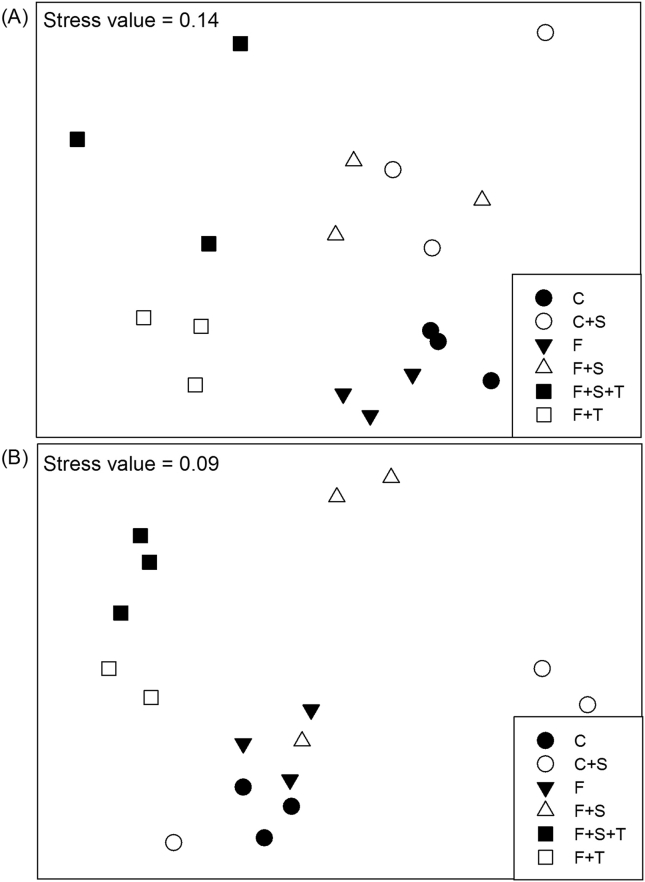
Bray-Curtis similarity-based non-metric multidimensional scaling plot (nMDS) of normalized TRFLP data obtained from MspI-digested 18S rDNA amplicons visualizing the differences in fungal community composition in the clayey (A) and sandy (B) soil according to the following treatments: uncoated maize (C), uncoated maize with S. hermonthica (C + S), coated maize with ‘Foxy-2’ (F), coated maize with ‘Foxy-2’ and S. hermonthica (F + S), coated maize with ‘Foxy-2’ and T. diversifolia (F + T) and coated maize with ‘Foxy-2’, S. hermonthica and T. diversifolia (F + S + T).